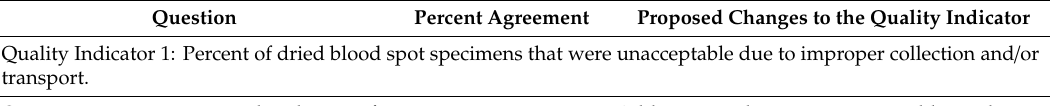
Table 6. Summary of results from the Delphi process for Quality Indicator